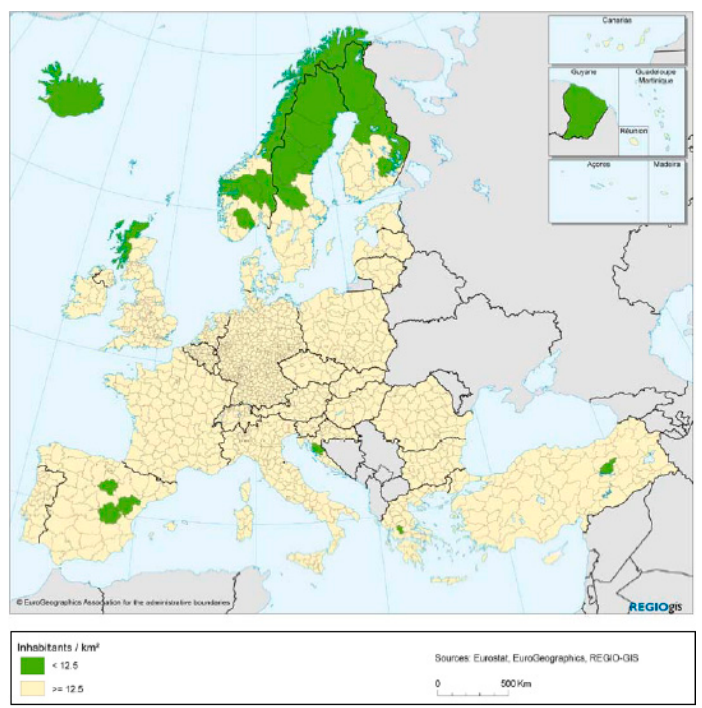
Figure 2. Sparsely populated regions. Source: Eurostat [12].